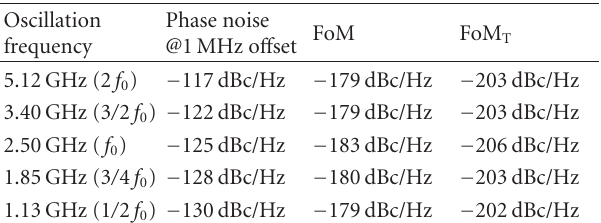
Table 2: Phase noise